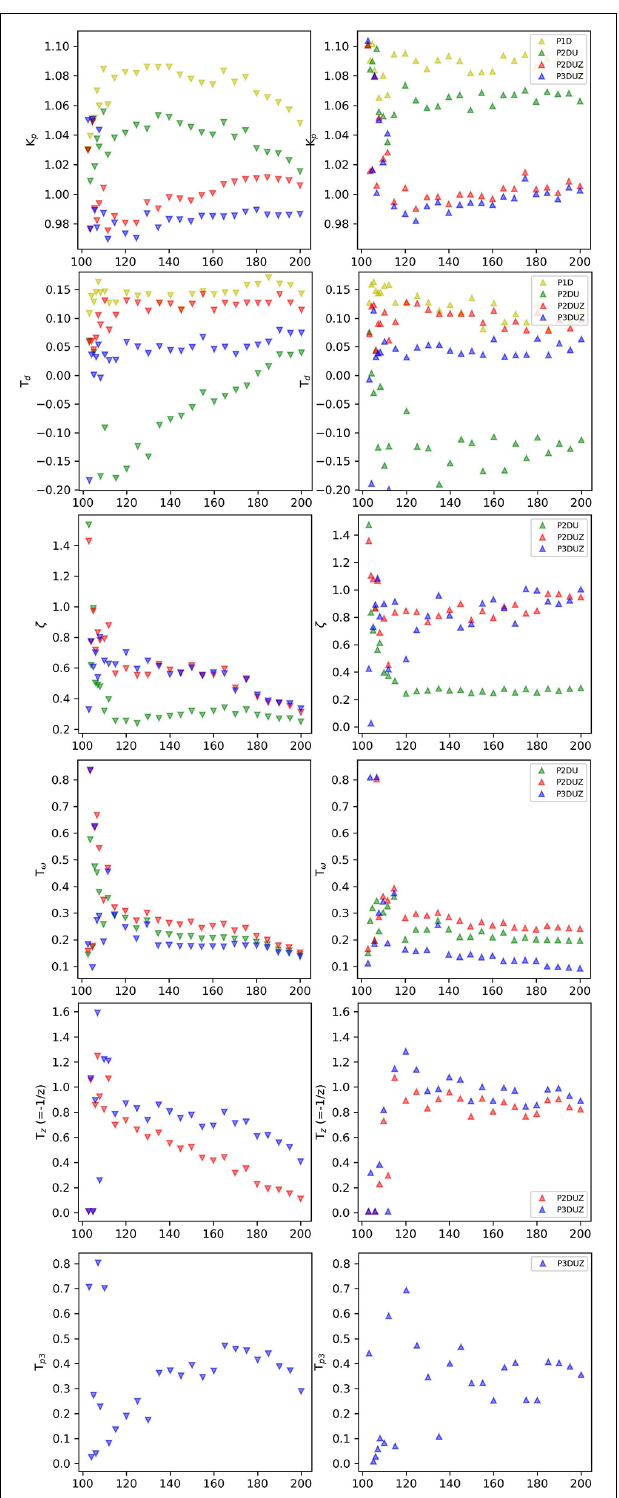
FIGURE 7 | Gain ( K p ), delay ( T D ), damping ratio ( ζ ), oscillation period ( T ω ), zero ( T Z -values), and the third pole ( T P 3 -values). The parameters of the aggregated data over participants for negative ( ∨ ) and positive ( ∧ ) steps, as reported by the relevant